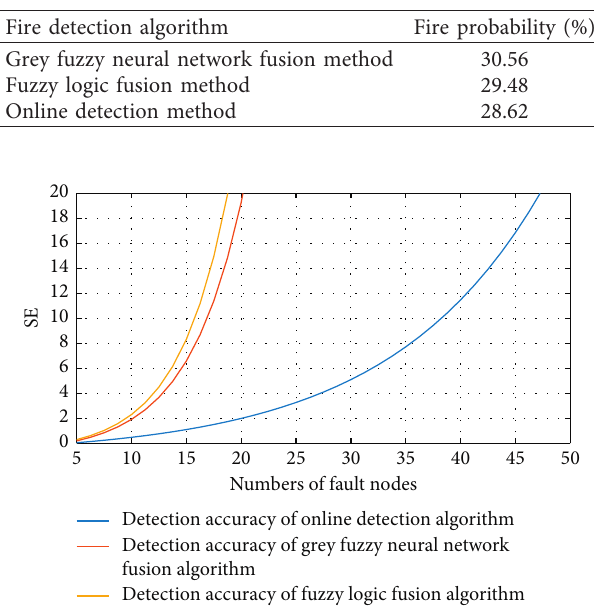
Figure 6: Comparison diagram of detection accuracy of three